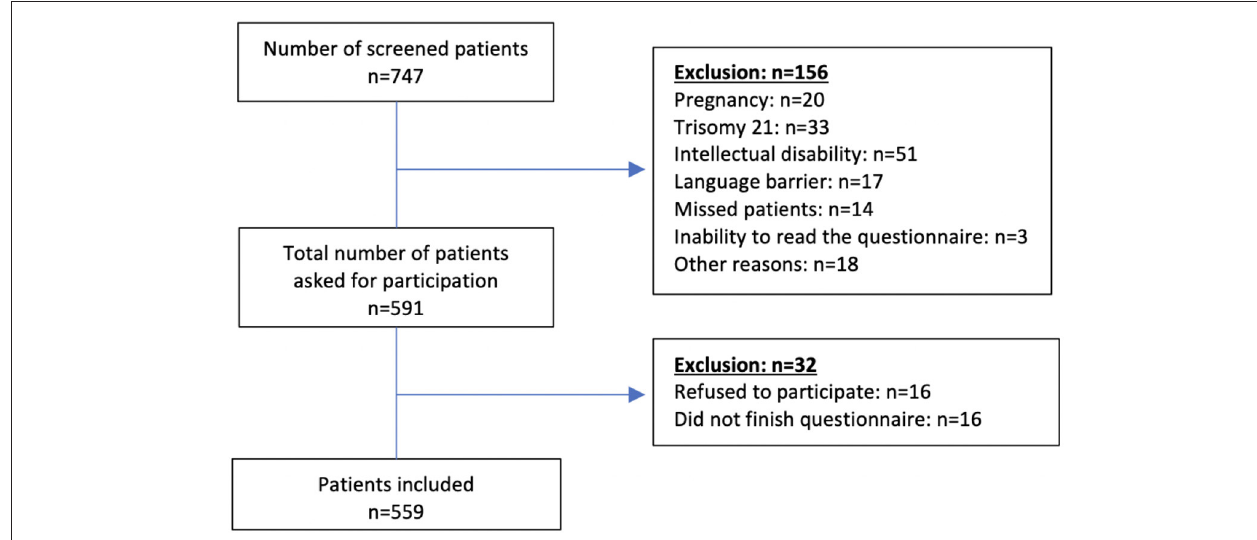
FIGURE 1 | Flowchart of included